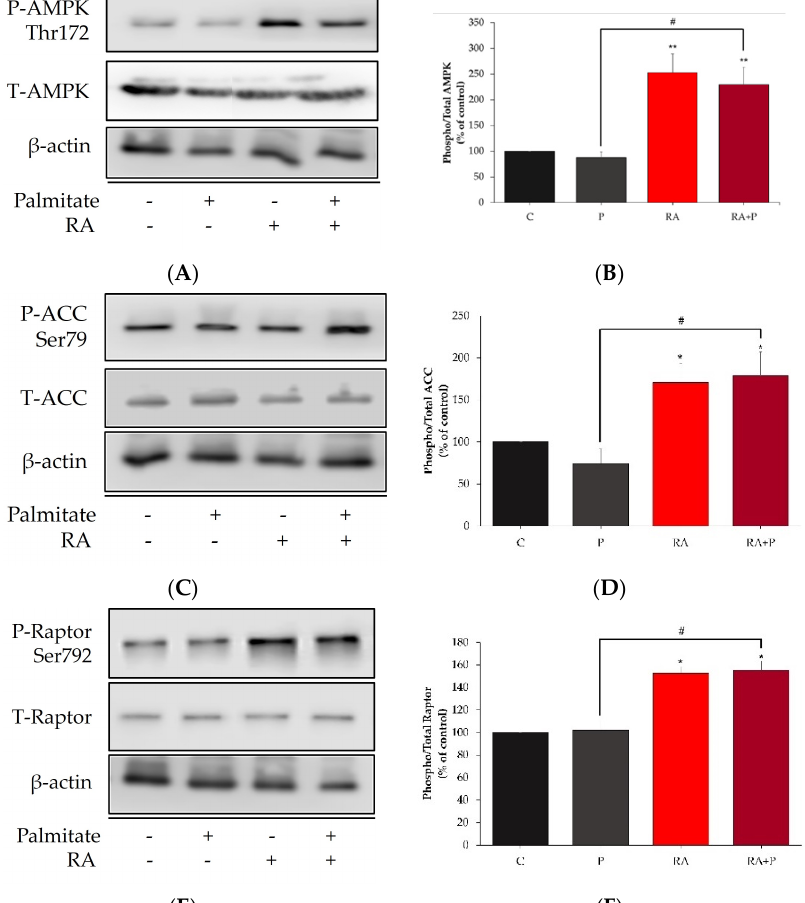
Figure 6. Rosmarinic acid phosphorylates AMPK ( A , B ), ACC ( C , D ), and Raptor ( E , F ). Fully differentiated myotubes were treated without (control, C) or with 0.2 mM palmitate (P) for 16 h in the absence or the presence of 5 μ M rosmarinic acid (RA). After treatment, the cells were lysed, and SDS ‐ PAGE was performed, followed by immunoblotting with specific antibodies that recognize phosphorylated Thr 172 or total AMPK, phosphorylated Ser 79 or total ACC, and phosphorylated Ser 792 or total Raptor. Representative immunoblots are shown ( A , C , E ). The intensity of the bands (arbitrary units) was measured using Image J software and expressed as percent of control ( B , D , F ). The data are shown as the mean ± SE of three separate experiments (* p < 0.05, ** p < 0.01 vs. control, # p < 0.05 vs. palmitate alone).